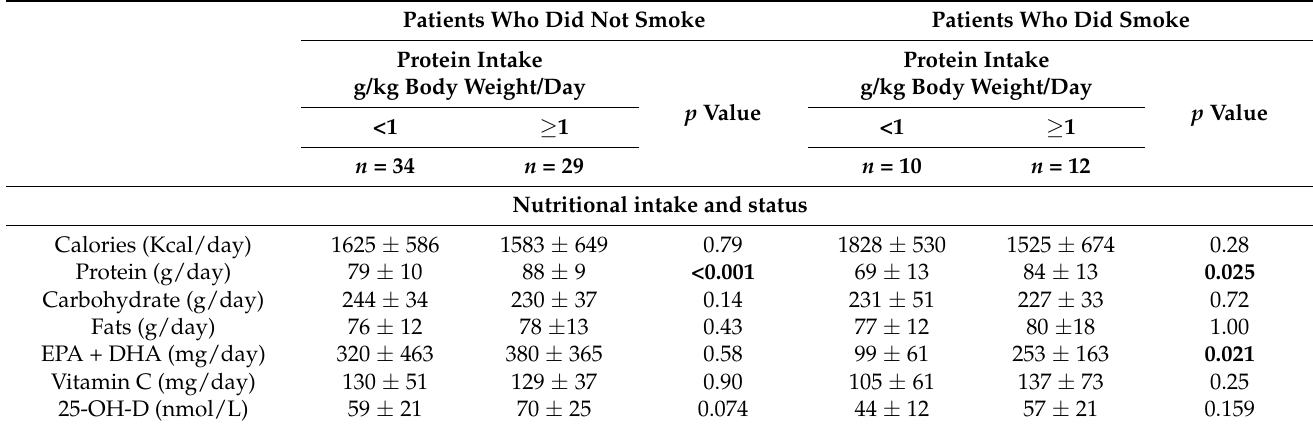
Figure 1. Flowchart illustrating recruitment and final sample size for patients undergoing non-sur- gical periodontal therapy. Reasons for exclusion of participants are given to the right of the arrows denoting the transitions between stages.